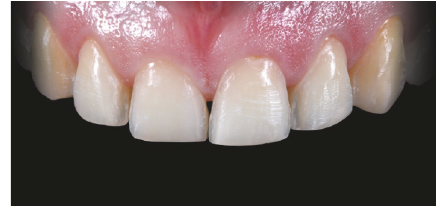
Figure 10: Digital model with the finished preparations for the ceramic digital design.